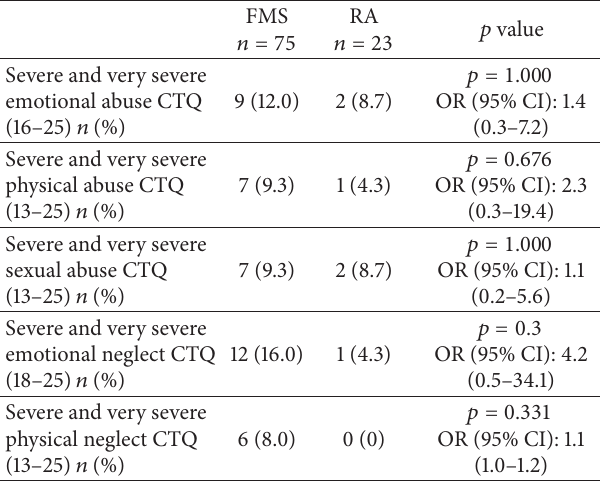
Table 7: Comparison of retrospective reports on childhood adver- sities (assessed by Childhood Trauma Questionnaire) of Israeli FMS patients and RA patients.